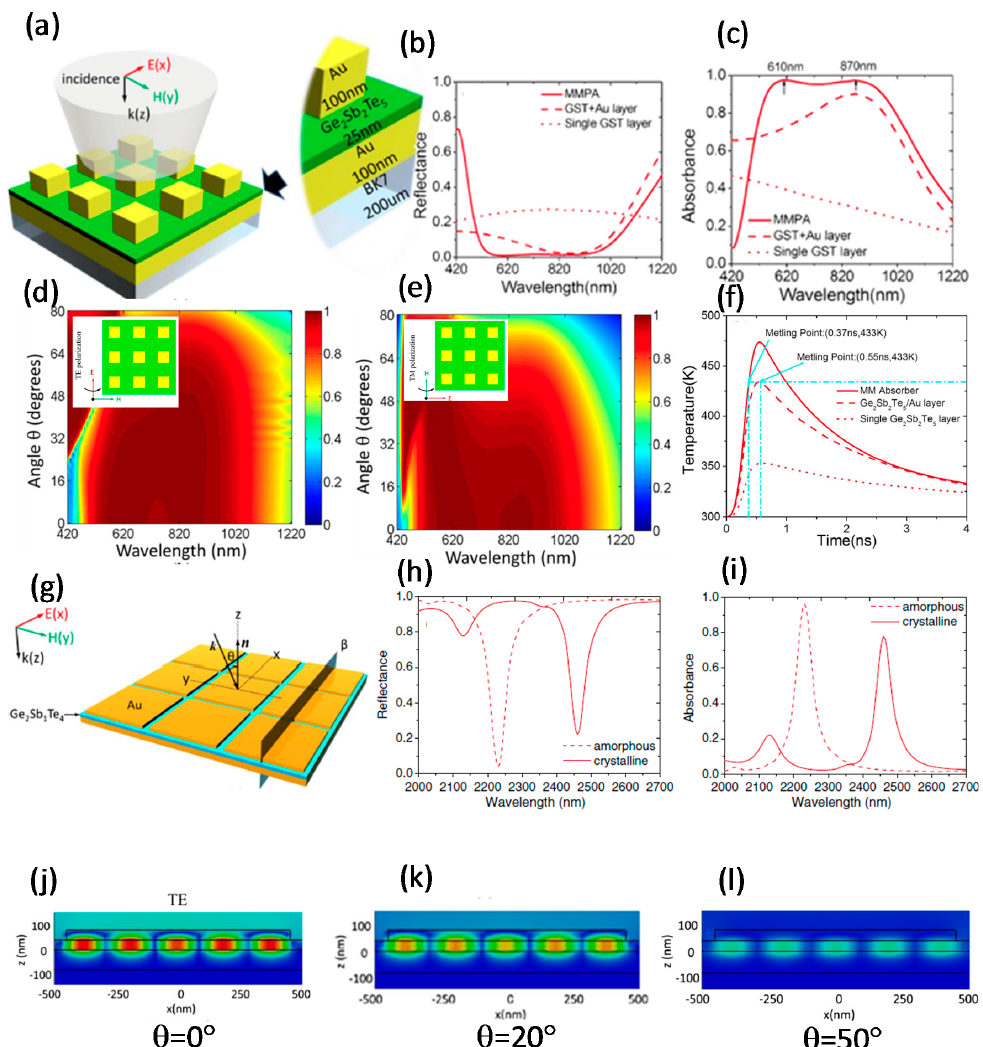
Figure 6. GST-based tunable absorbers. ( a ) Structural representation of the broadband absorber with incident light polarization; Simulated spectra of ( b ) reflectance and ( c ) absorbance for three configurations including a perfect absorber, hybrid, and single GST layer; Simulated absorbance peak distribution for ( d ) TE and ( e ) TM polarization of GST amorphous film; ( f ) The simulated temperature of one pulse through the perfect absorber, hybrid, and single GST layer; ( g ) Graphical representation of the absorber structure with the incident light polarization while the incident angle of the plane wave on the surface is θ ; Simulated ( h ) reflectance and ( i ) absorbance spectra of GST layer at perpendicular incidence; Scattered magnetic field of TE polarization at different angles of ( j ) θ = 0°, ( k ) θ = 20°, ( l ) θ = 50°. ( a – f ) are adapted from [28], with permission from © 2014 Nature Publishing Group; and ( g – l ) are adapted from [59], with permission from © 2013 OSA.